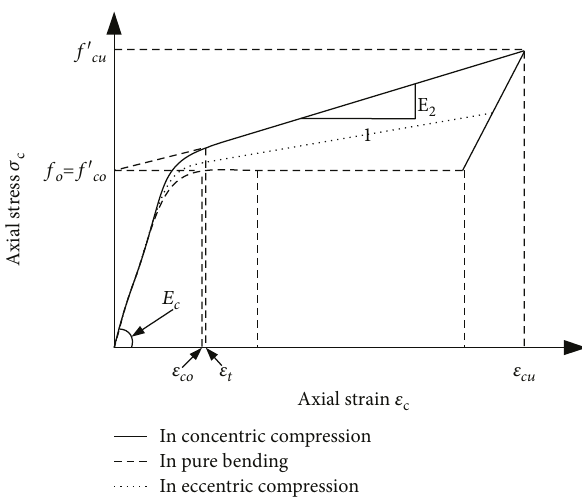
Figure 1: Stress-strain models for concrete in FRP-jacketed composite